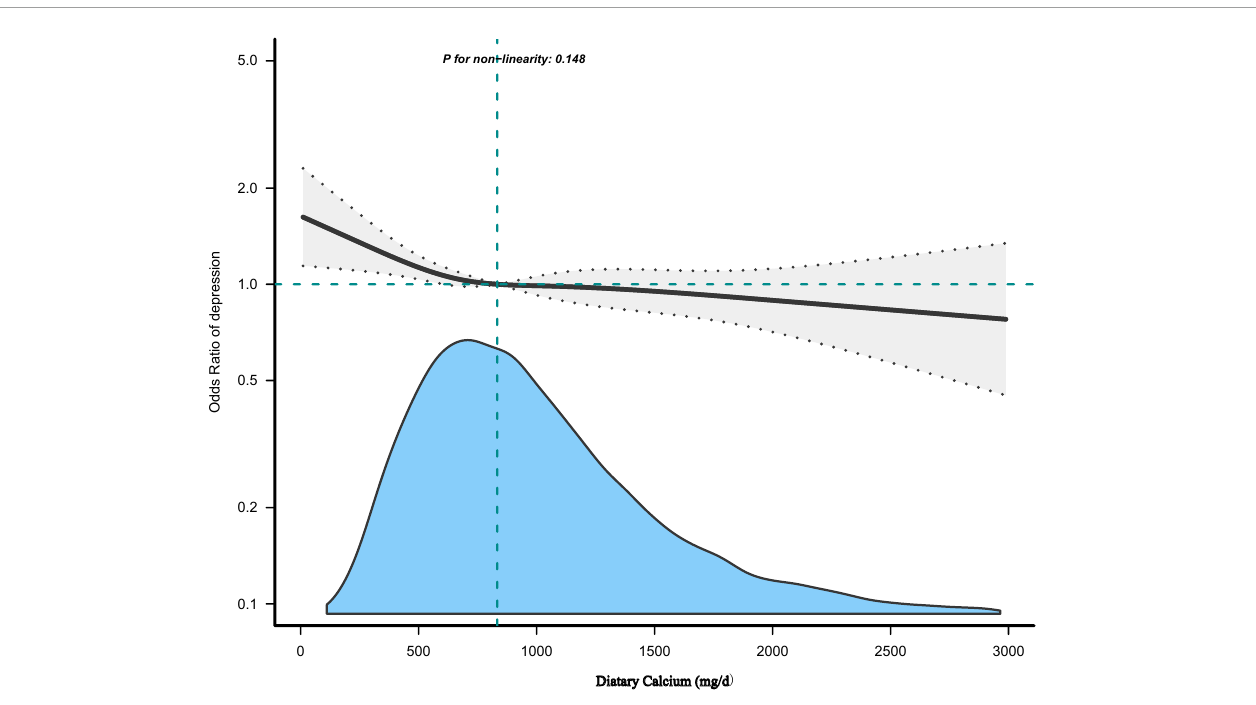
FIGURE2 The dose-response relationship between dietary calcium (Ca) intake and the risk of depressive symptoms. Adjusted for: Age + sex + hypertension + diabetes + CVD + cancer/malignancy + race/ethnicity + education + marital status + poverty to income ratio (PIR) + body mass index (BMI) +